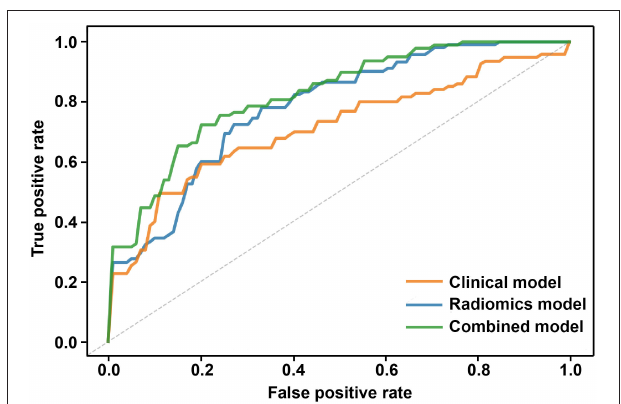
FIGURE 2 | Comparison of ROC curves based on 5-fold cross-validation among the three models. The clinical model is marked with an orange curve, and the AUC is 0.71 (95% CI 0.62–0.80). The radiomics model is marked with a blue curve, and the AUC is 0.78 (95% CI 0.71–0.85). The combined model is marked with a green curve, and the AUC is 0.82 (95% CI